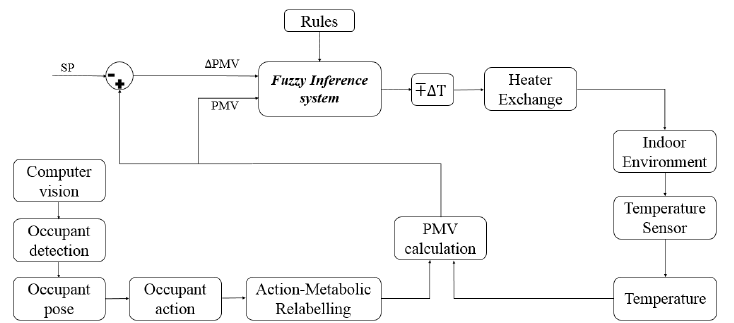
Figure 1. Fuzzy temperature control based on occupant action and the PMV index for thermal